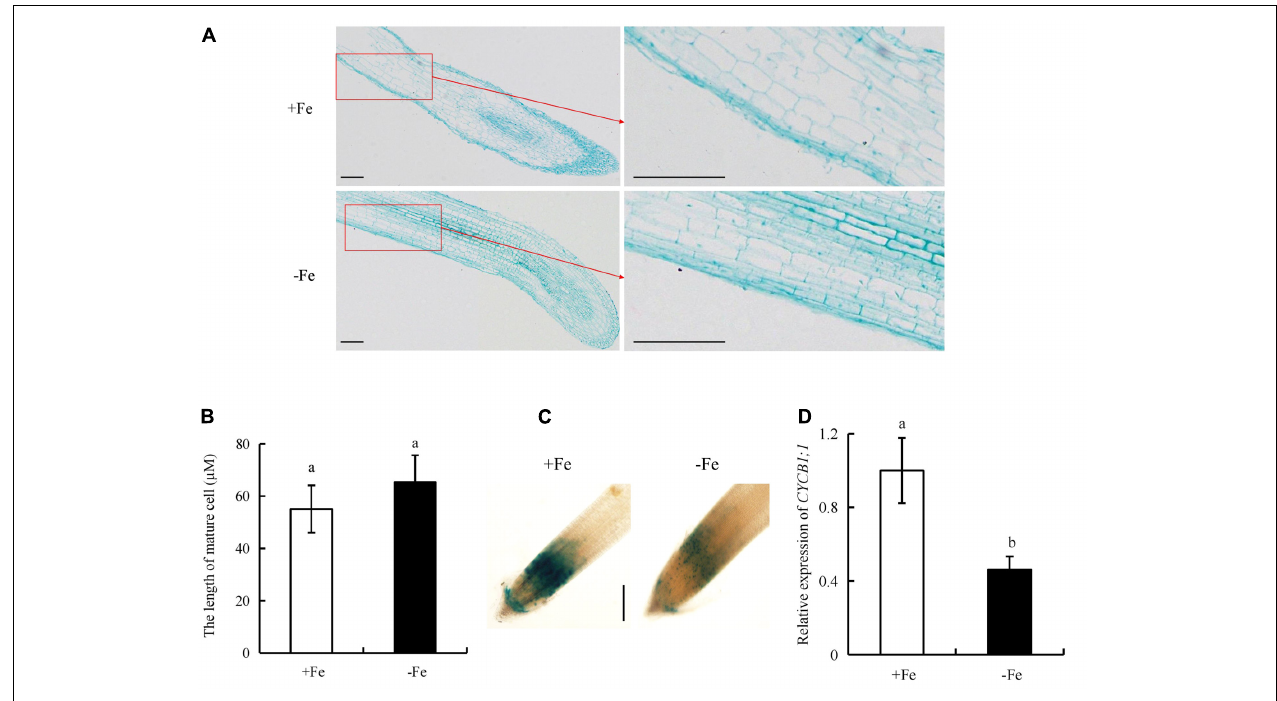
FIGURE 9 | Epidermal cell lengths in the maturity zone, expression levels of pCYCB1;1::GUS and OsCYCB1;1 in the meristem zone. Seedlings were grown in hydroponic media containing − Fe (0 µ M) and +Fe (20 µ M) for 14 days. (A,B) Epidermal cell length of seminal root. Bar = 100 µ m. (C) Cell cycle activity of the root meristemof seminal root, as monitored by the pCYCB1;1::GUS reporter. Bar = 500 µ m. (D) The expression of CYCB1;1 gene. Data are means ± SE and bars with different letters indicate significant difference at P < 0.05 tested with ANOVA.